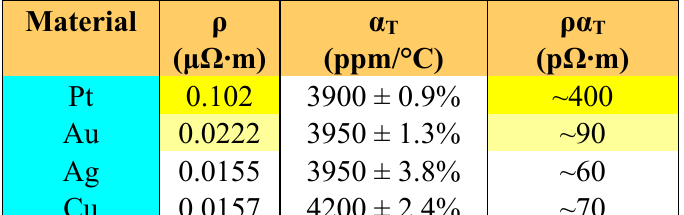
Table 2. Compared resistivity of metals [21].